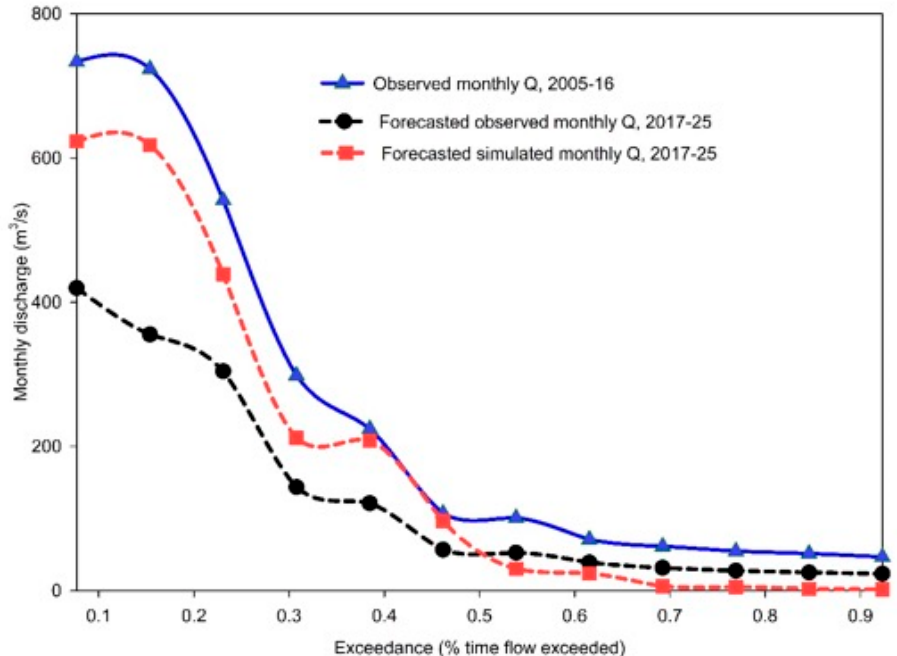
Figure 9. Flow–duration curves for the monthly observed, forecasted observation-based, and SWAT- simulation-based Lhasa River